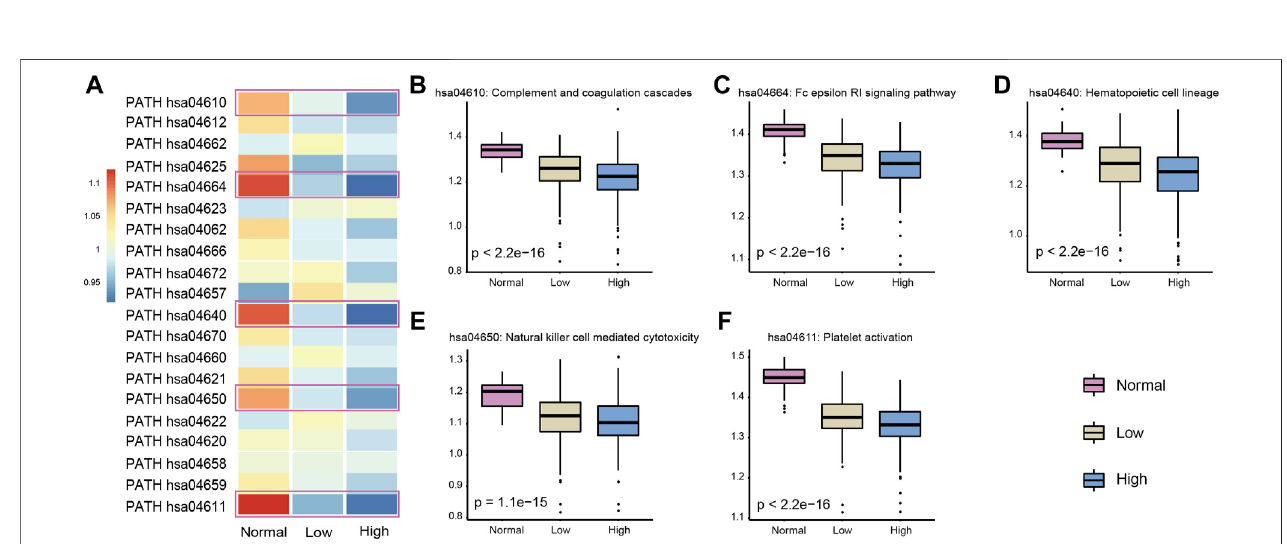
FIGURE 4 | Selected fi ve immune pathways were most related to the LUAD cancer status. (A) Activity score of each immune pathway in three groups was calculatedbytheJasonW.Locasalemethod.Theselected fi veimmunepathwaysweremarkedwithboxes. (B – F) Activityscoreof fi veimmunepathwaysinthreegroups was calculated by the ssGSEA algorithm. p -values were obtained by Kruskal –